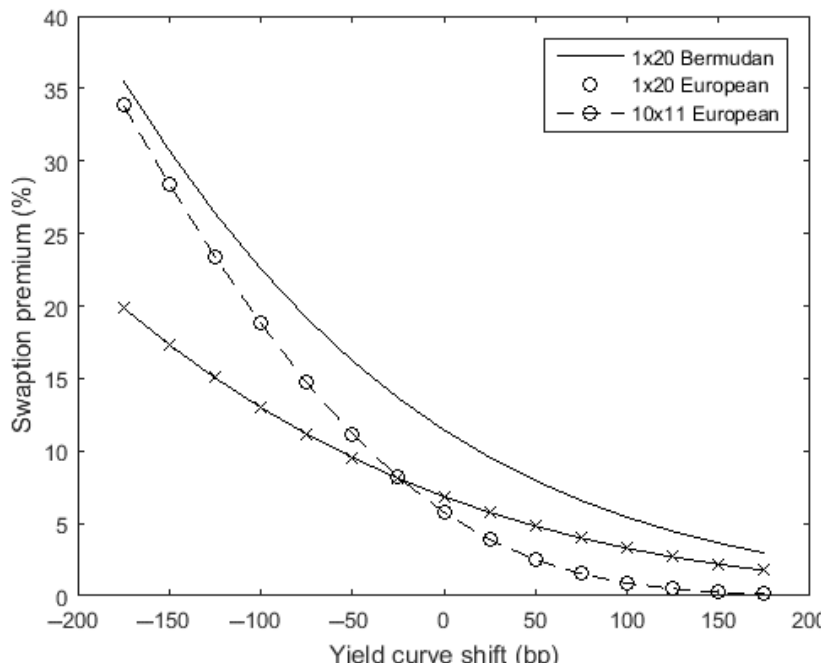
Figure 3. The 21nc1 Bermudan swaption and its most expensive Europeans in different mar- ket